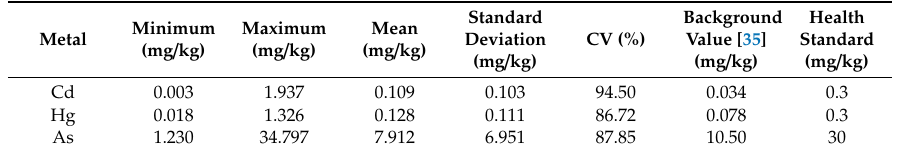
Table 1. Statistical parameters of the measured content of heavy metals in soil in Guangdong, China (Stdev: standard deviation; CV: coe ffi cient of